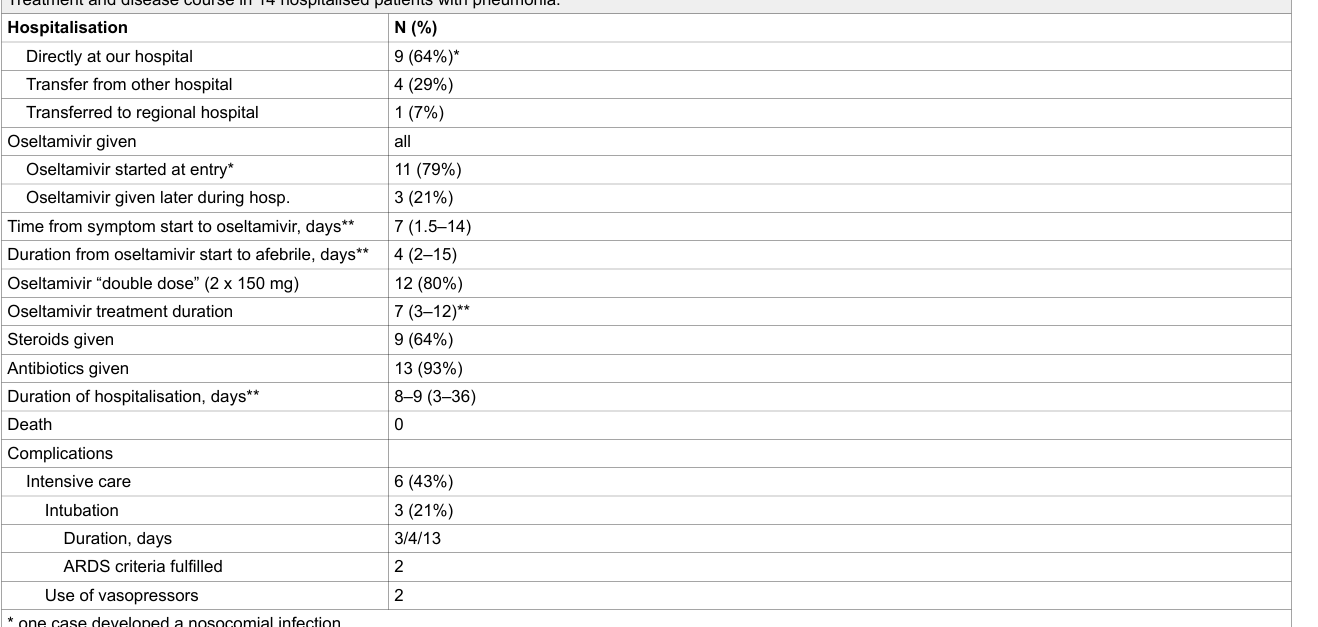
Table 2 Treatment and disease course in 14 hospitalised patients with